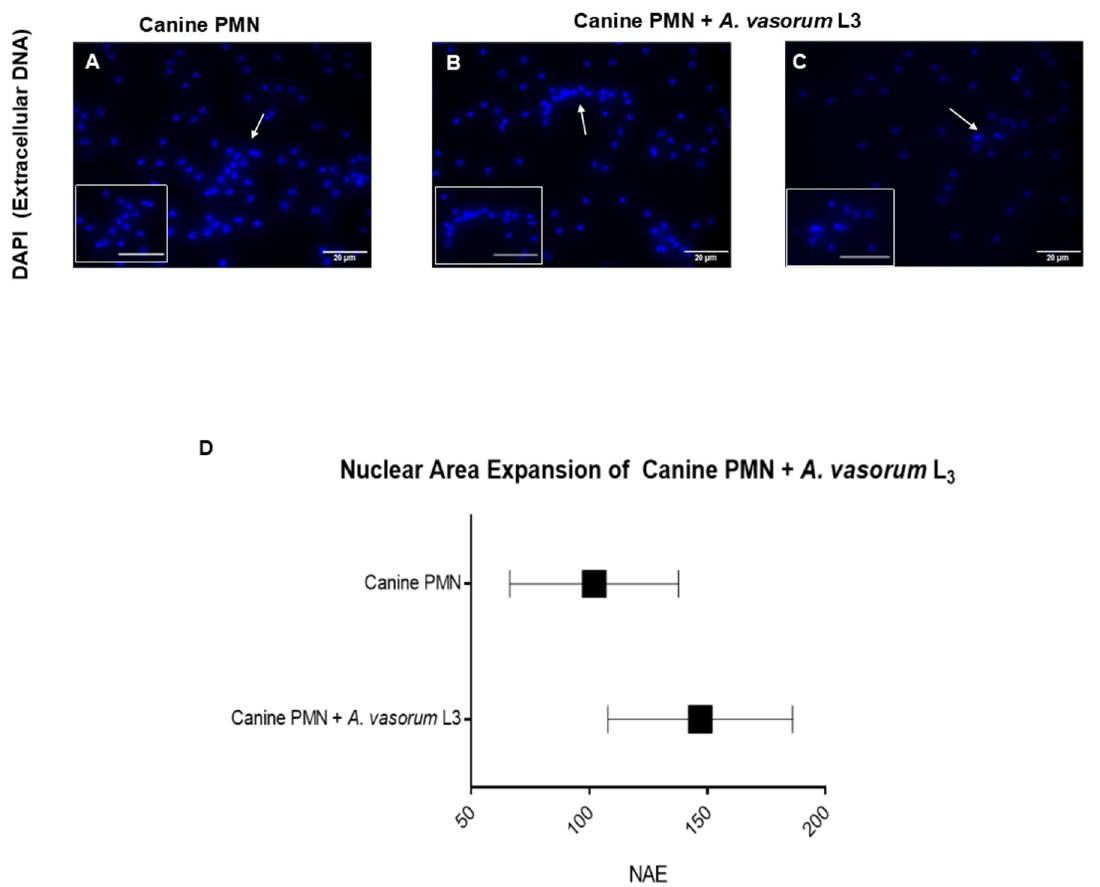
Figure 3. Nuclear expansion (NAE)-based quantification of A. vasorum L3-triggered NETs. Canine PMN were incubated in cell medium alone or exposed to A. vasorum L3. ( A ) depicts canine PMN alone; ( B , C ) illustrates co-cultivation of canine PMN + A. vasorum . Box placed on the left bottom depicts an isolated magnification of canine PMN alone and canine PMN co-cultured with axenic A. vasorum L3. NAE was analyzed by ImageJ ® and DANA software. ( D ) shows the nuclear area increase of NETotic cells after co-cultures.